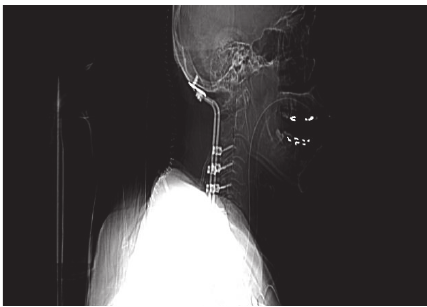
Figure 4: CT cervical spine after surgery showing removal of the